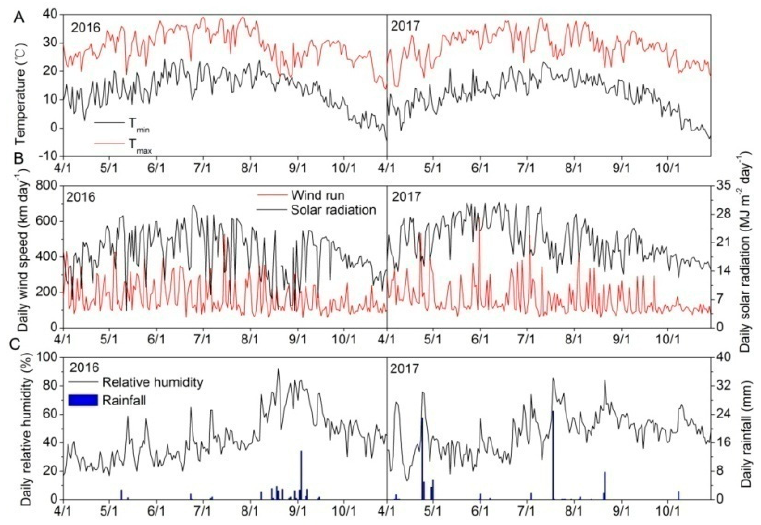
Figure 8. Daily maximum and minimum temperature ( A ), wind speed and solar radiation ( B ), relative humidity and rainfall ( C ) at the experimental site during the cotton growing period (April–October) in 2016 and 2017.